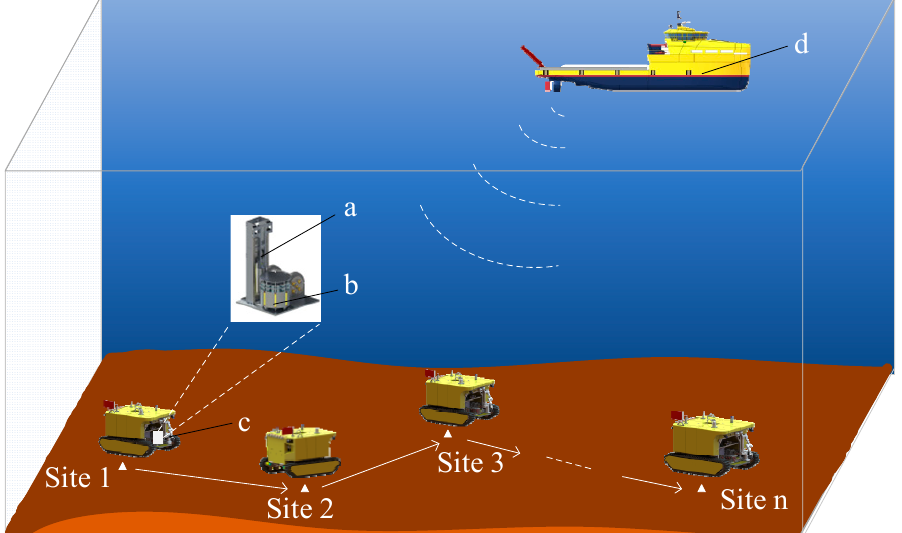
Figure 1. Schematic sketch of the demonstration mission. (Note: a—multipoint sampler; b—sampling structure; c—DSLV; d—research vessel).